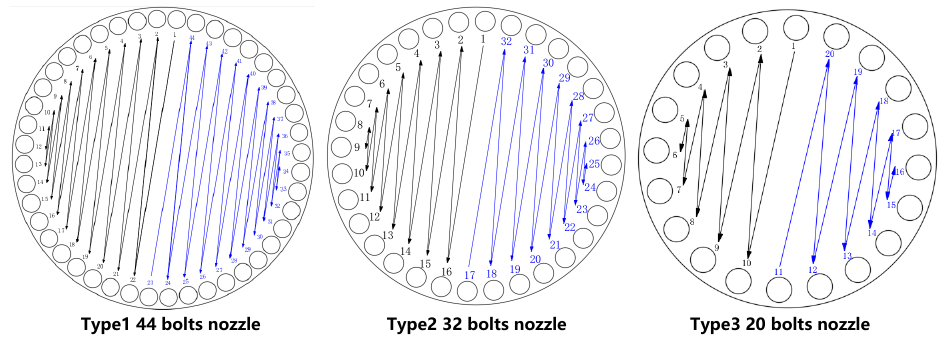
Figure 16. Tightening sequence of aerospace engine